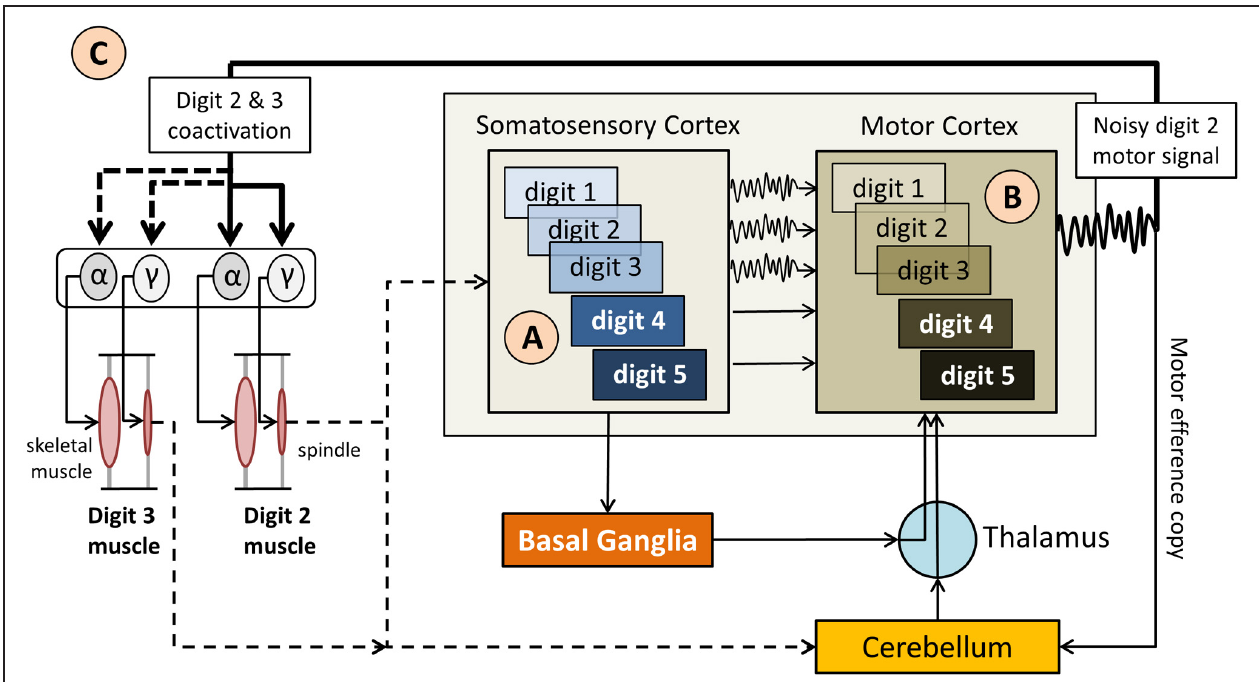
FIGURE 2 | Simplified diagram of the sensorimotor network in musician’s dystonia. (A) “Smeared” overlapping somatosensory representations of the hand digits (indicated as 1–5) provide imprecise, noisy feedback ( ) to the motor cortex, which also has overlapping motor representations of the digits. (B) The resulting motor signal originates from motor neurons representing multiple digits, i.e., are not finely tuned. (C) . As a